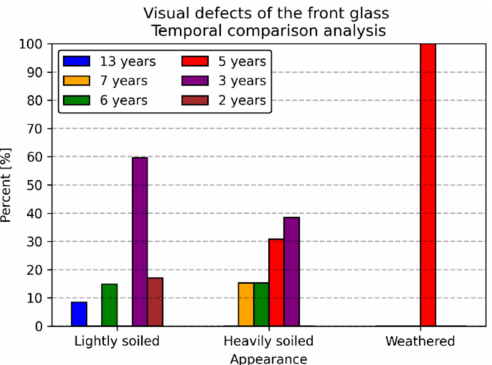
Figure 8. Temporal comparison of front glass failures/defects.